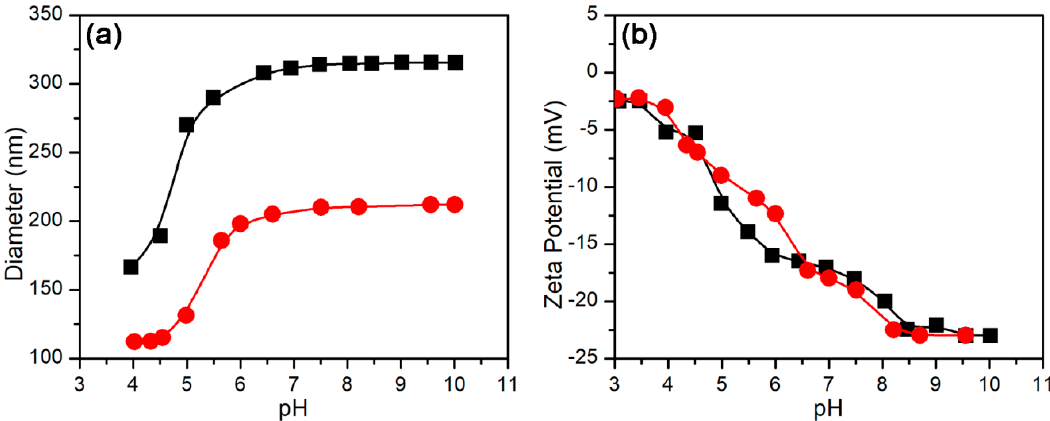
Figure 2. Effect of pH on ( a ) hydrodynamic diameter and ( b ) zeta potential of diblock polymer brushes. ( ■ ) PSV@PNIPA- b -PAA, ( ● ) PSV@PAA- b -PNIPA.